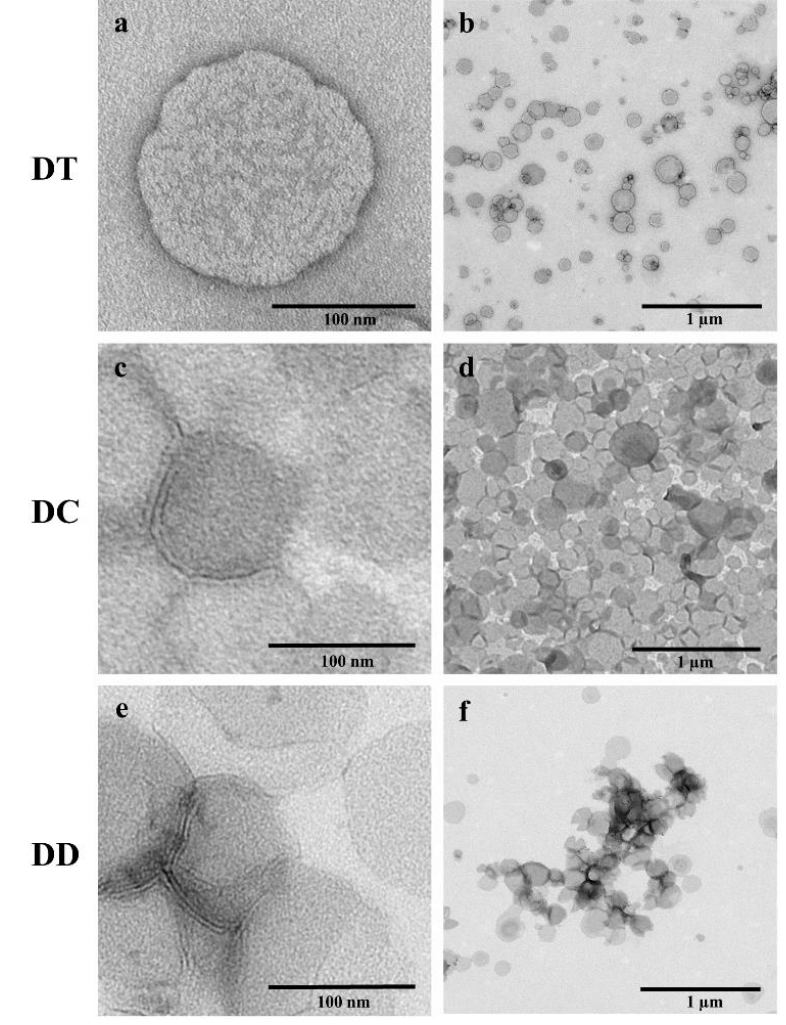
Figure 4. Transmission electron microscope (TEM) images of the liposomal formulations DT, DC and DD after nebulisation, containing a curcumin concentration of 100 µM. The samples were negatively stained with 2% uranyl acetate. Scale bars represent 100 nm for the images ( a , c , e ) and 1 µm for the images ( b , d , f ) .